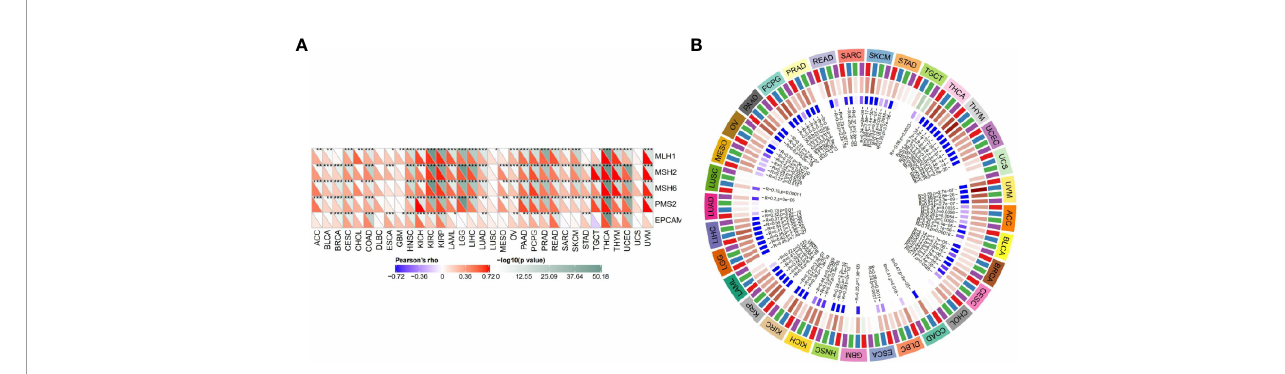
FIGURE 7 | Correlation analysis between the expression of ATG5 in pan-cancer and the expression levels of DNA repair genes and methyltransferases. (A) Correlation analysis between gene expression levels of the fi ve MMRs and ATG5 expression. (B) Correlation analysis between ATG5 expression and the expression offour methyltransferases. DNMT1 is colored red, DNMT2 was colored blue, DNMT3a was colored green, and DNMT3b is colored purple.